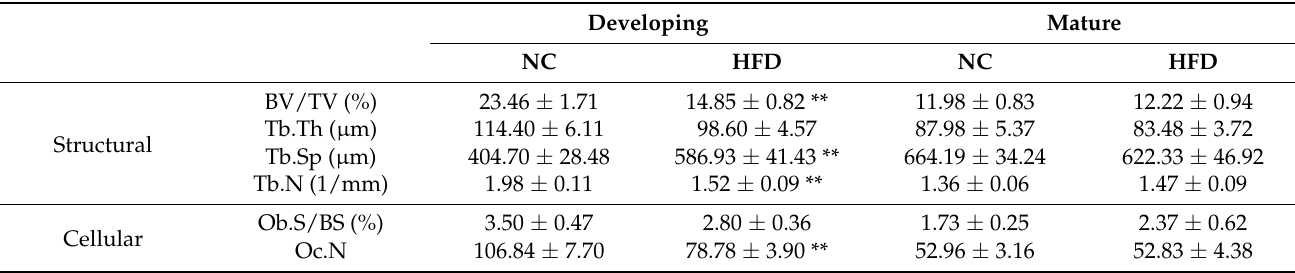
Table 2. The 2D histomorphometry of trabecular bone in normal chow and high fat diet mice of developing and mature age groups.